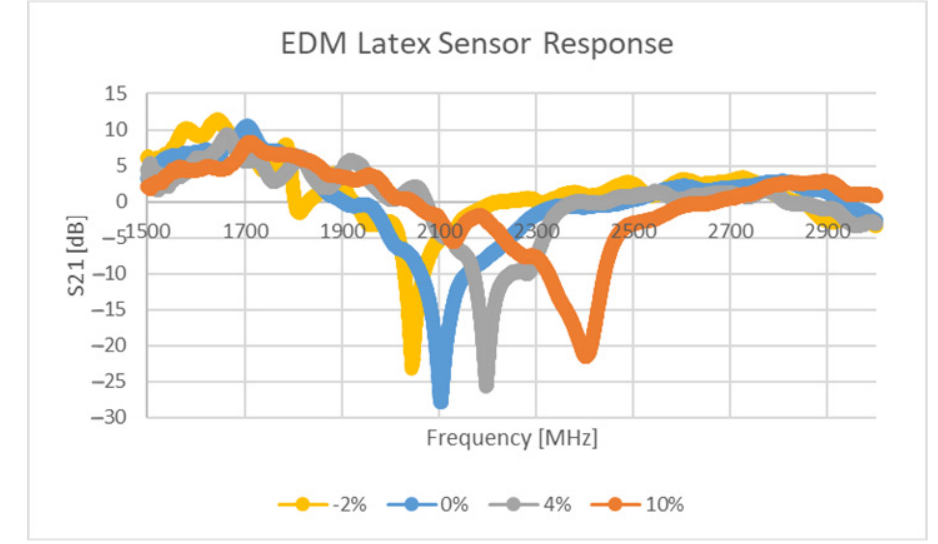
Figure 15. Response of sensor at two different stimulus levels.